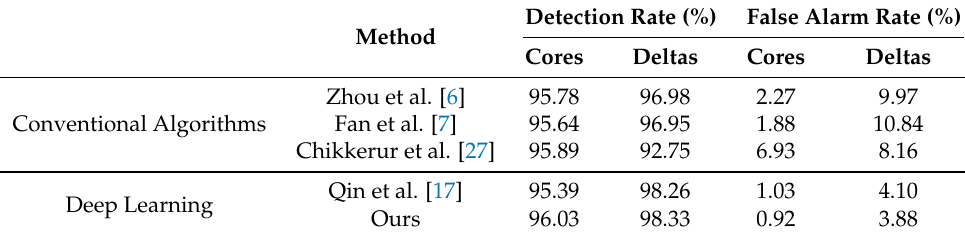
Table 1. The performance comparisons with different algorithms on FVC2002 DB1 dataset.